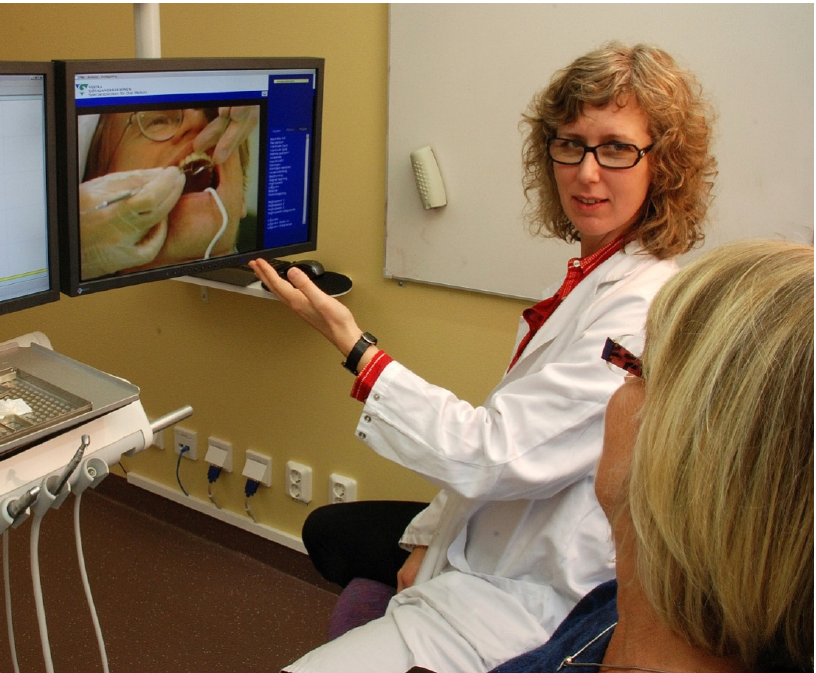
Figure 6. The CBT treatment setting, psychologist providing exposure in the dental operating room [34]. In 2017, Region Västra Götaland in Sweden decided on new regional clinical guide- lines for adult individuals with severe dental anxiety/phobia, including the provision of specialised CBT administered by psychologists working in interdisciplinary collaboration with dental personnel at the same dental clinic to patients in the region. Systematic liter- ature reviews, including meta-analyses, have clearly indicated CBT as the most effective treatment for adult individuals with severe dental anxiety [28–31]. These regional clinical guidelines improve the treatment for dental anxiety patients and make it available to all citizens in the region, thereby providing more equal evidence-based dental care. In our experience, the CBT must be provided at a dental clinic for the following rea- sons: (i) for the psychologist to deliver evidence-based treatment (CBT with exposure), the setting must be a dental treatment room with access to anxiety-provoking stimuli and situations; (ii) to complete CBT, the patients need to participate in behavioural experi- ments, that is, to undergo dental treatment; (iii) most of our patients have severely deteri- orated oral status and, therefore, the CBT must be planned and integrated with dental treatment in a sensible way. 7. Concluding Remarks There are other models for dental anxiety treatment in other countries. In Norway, for instance, dentists specialised in dental anxiety provide the CBT for dental anxiety after undergoing CBT training. In the Netherlands, psychologists provide part of the CBT in more complex cases followed by exposure therapy by the specialised dentist. However, in these countries, psychologists take an active part in the assessment and treatment plan- ning for each patient. Also, one-session interventions have been presented [35–37]. There are obviously many reasons for the variations in the forms of interventions to treat dental